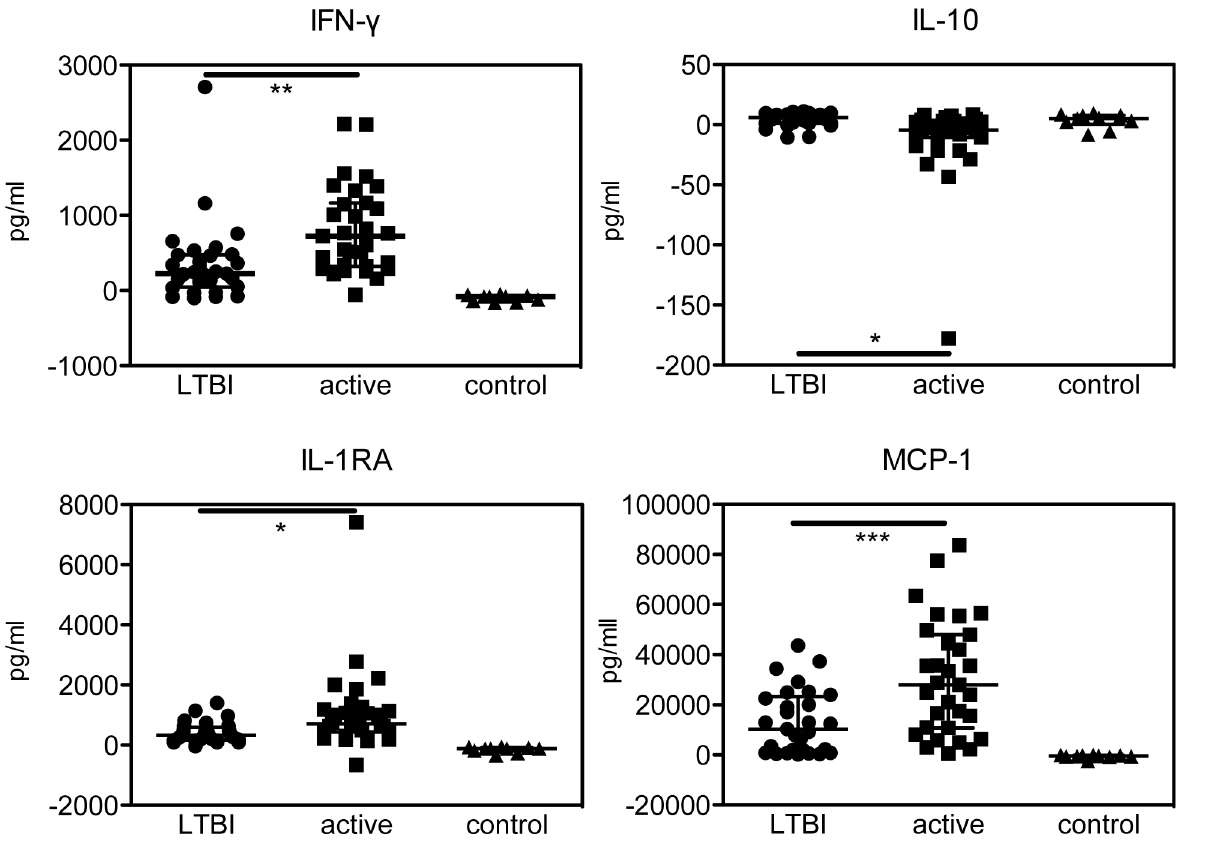
Fig 1. Major cytokines in TBAg – Nil supernatants of patients with active TB, LTBI and healthy controls. *** P < 0.001 and ** P < 0.01 between active TB vs. LTBI. Bars represent means, and error bars represent the SEM.